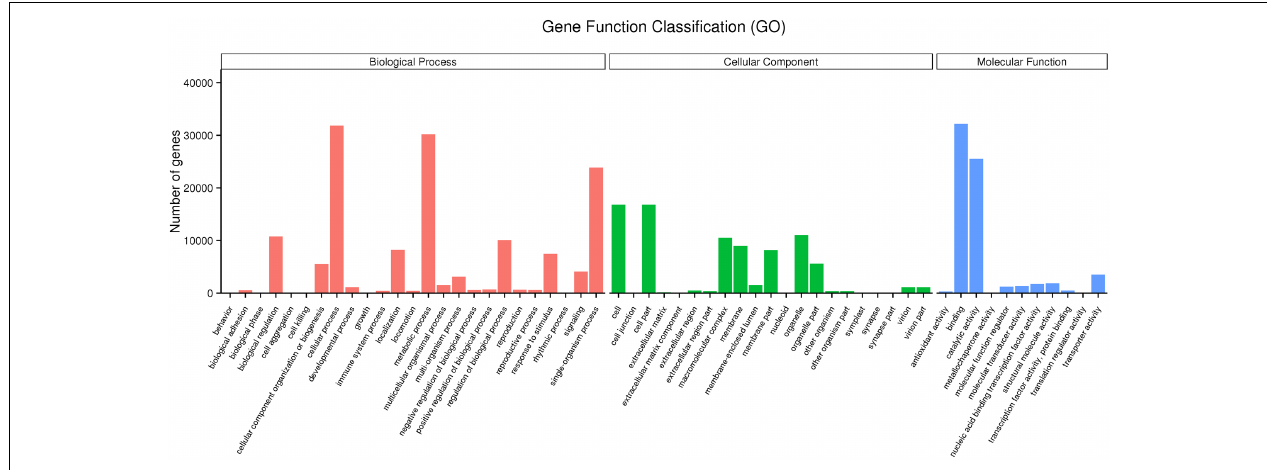
FIGURE 1 | Gene ontology (GO) annotations of non-redundant consensus sequences of perennial ryegrass. Best hits were aligned to the GO database, and most consensus sequences were grouped into three major functional categories namely, biological process (BP), cellular component (CC), and molecular function